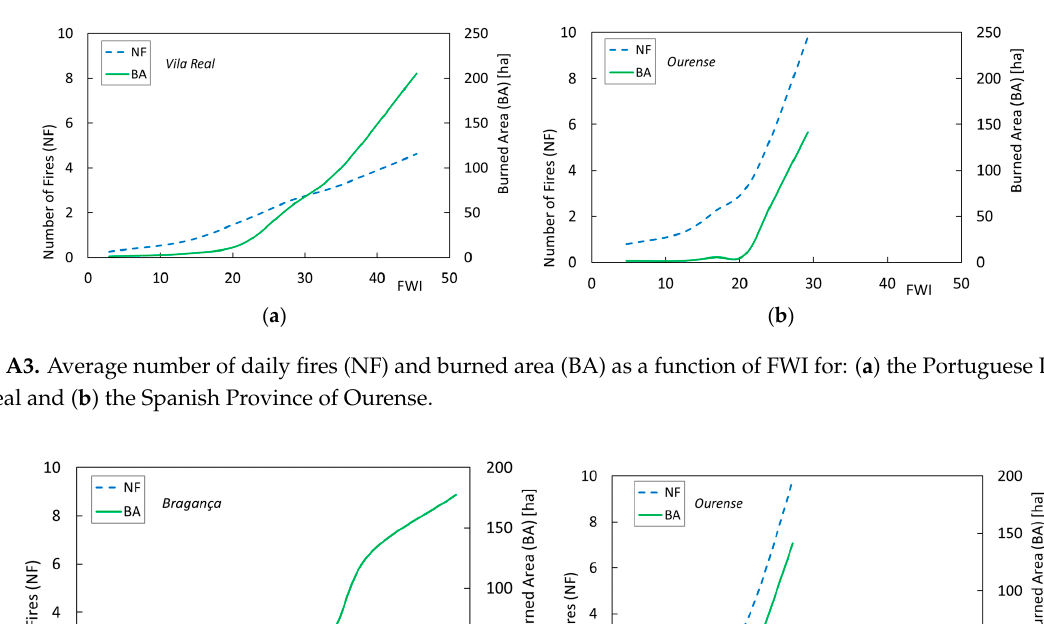
of Braga and ( b ) the Spanish Province of Ourense.